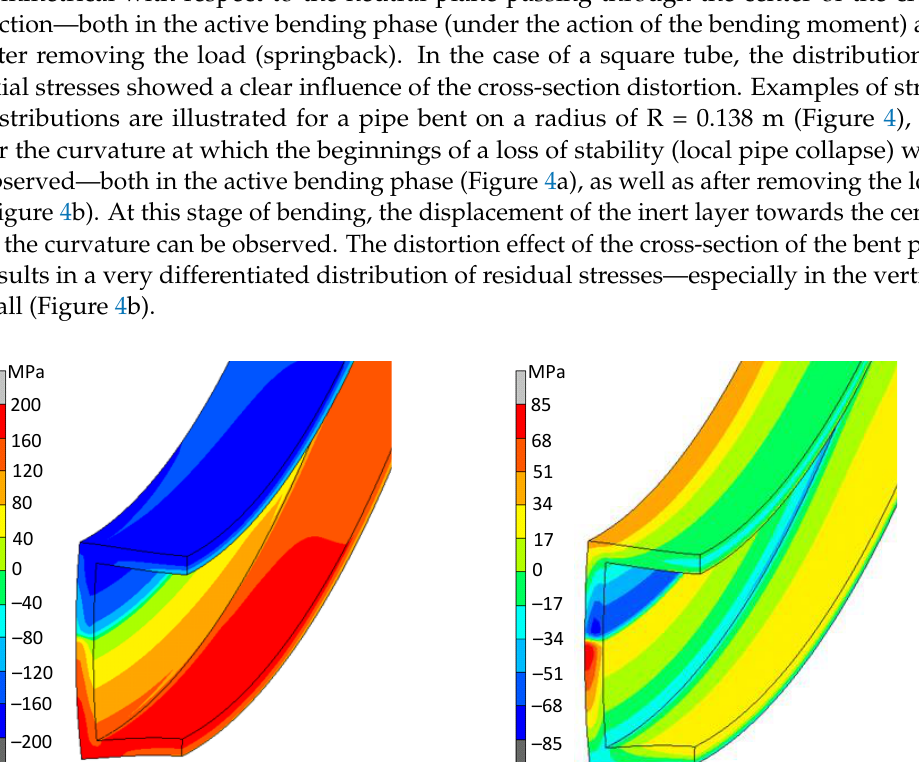
Figure 3. Distribution of Huber–Mises equivalent stresses on the cross-section of a tube with dimensions of 21.5 × 21.5 × 1.8 mm ( a ) and a bar with dimensions of 21.5 × 21.5 mm ( b ), bent on the radius of the value R = 0.147 m.